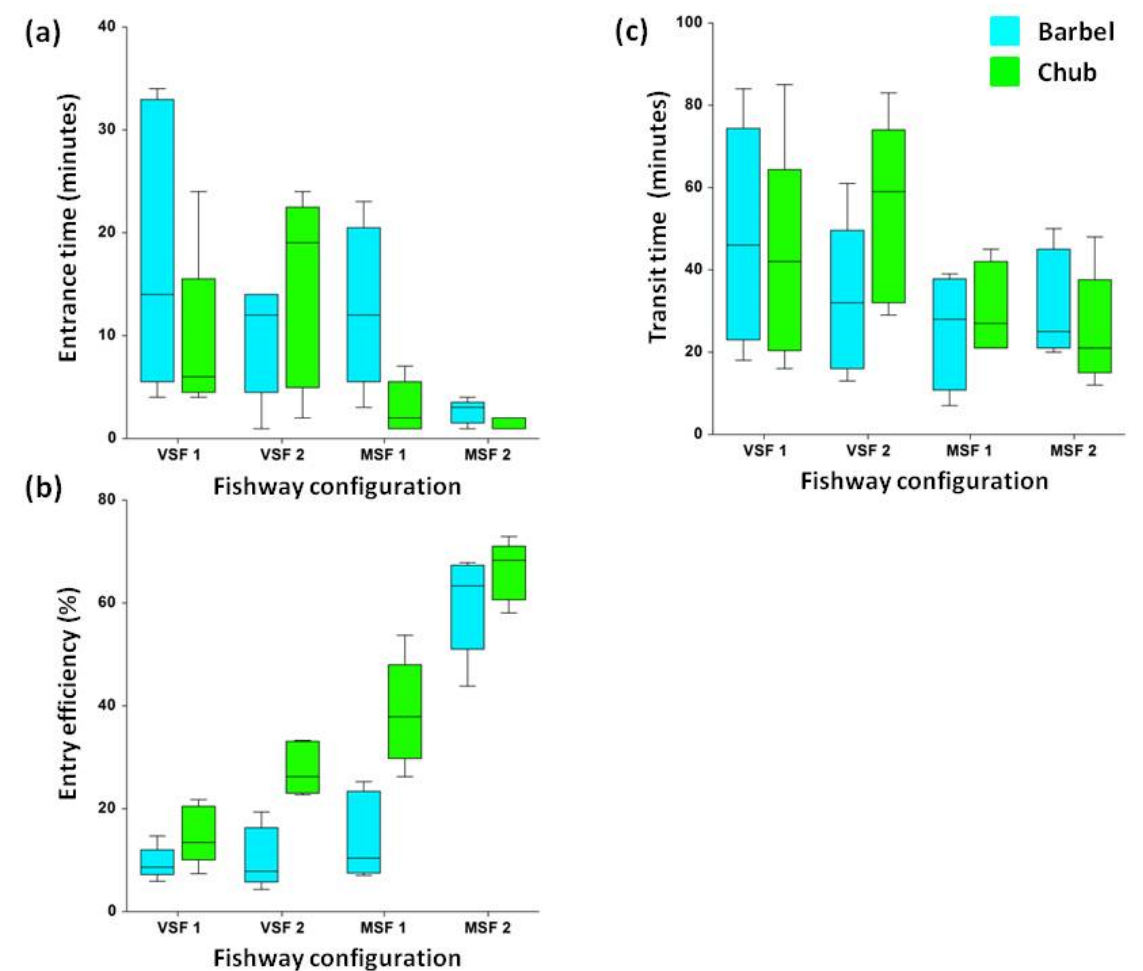
Figure 2. Luciobarbus bocagei (barbel) and Squalius pyrenaicus (chub) passage performance in the different fishway configurations tested: vertical slot fishway (VSF) 1—Q = 112 L · s − 1 , VSF 2—Q = 80 L · s − 1 ; multislot fishway (MSF) 1—Q = 58 L · s − 1 , MSF 2—Q = 37 L · s − 1 . ( a ) Entrance time—the time for the fastest fish to pass the first slot; ( b ) entry efficiency—the total number of fish passing the first slot divided by the number of corresponding attempts; ( c ) transit time—the time of the fastest fish reached the upstream end of the fishway. (Q, discharge).